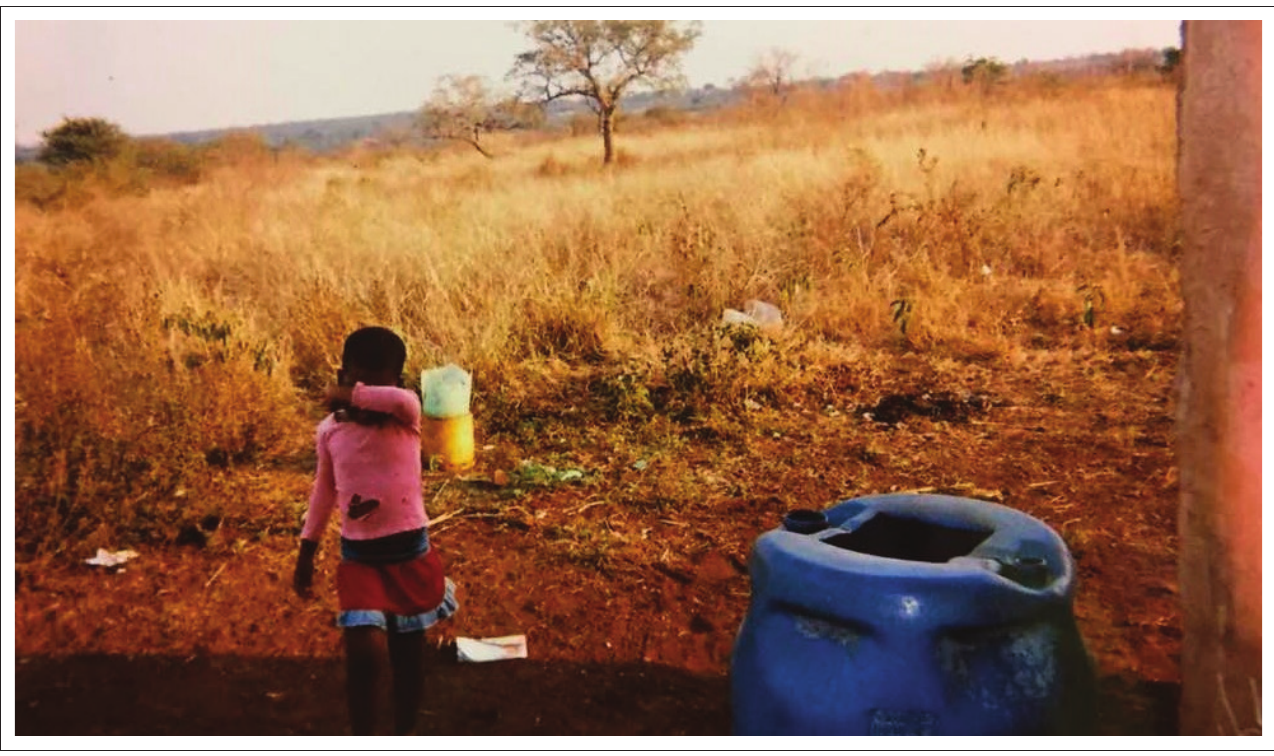
Source : Photo courtesy of Ncamsile Motsa. FIGURE 3: This picture shows Mbuso’s younger sister who forms part of his primary responsibilities besides caring for his sick mother and whole